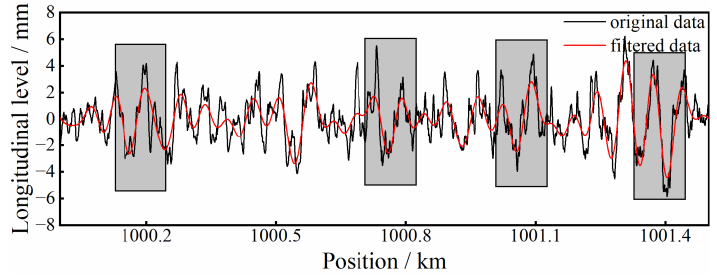
Figure 12. Waveform samples of subgrade frost-heave.